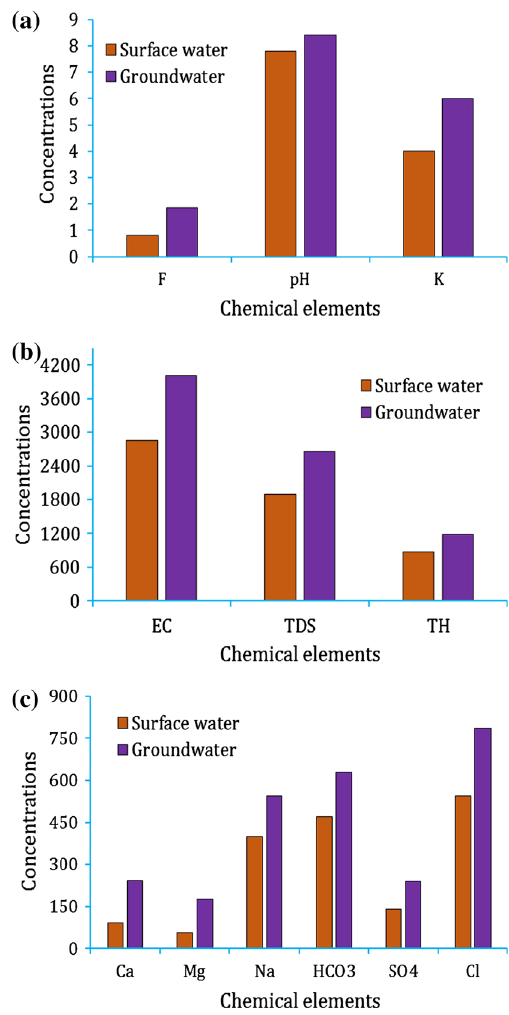
Fig. 14 Physico-chemical parameters concentrations and variation between groundwater and surface water samples in Mothkur region, Telangana State, South India